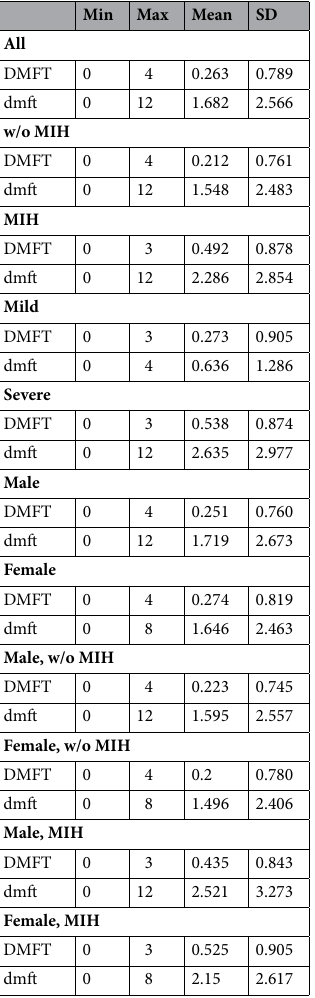
Table 3. Caries experience (DMFT/dmft) in the whole sample and in the different subgroups (female, male, with/without